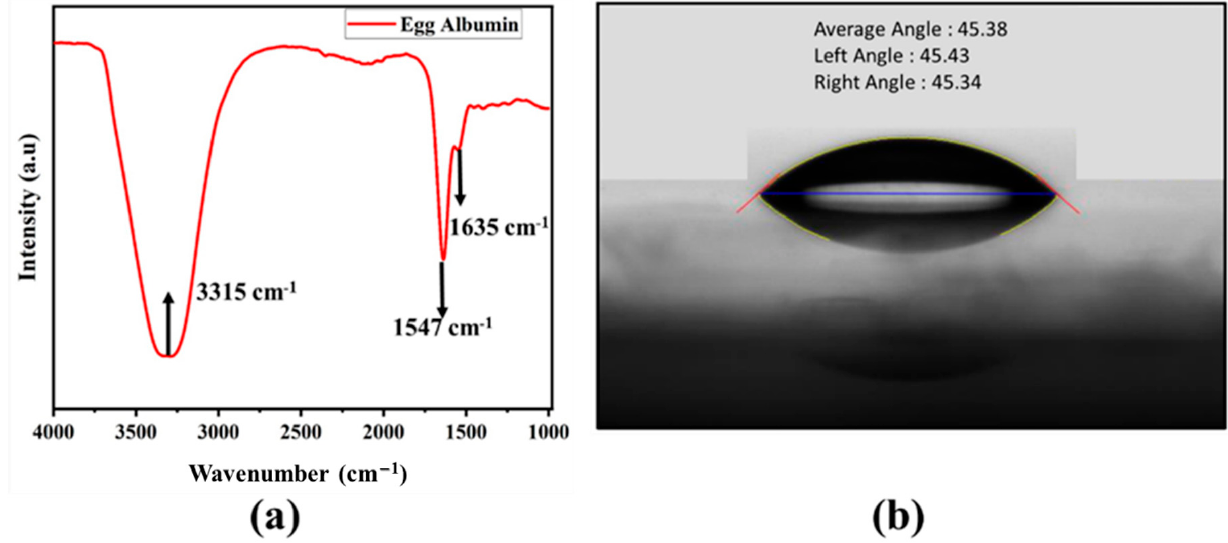
Figure 5. ( a ) Chemical composition and structure of functional layer depicted in FTIR spectrum of EW. ( b ) Contact angle of EW thin film showing its hydrophilic